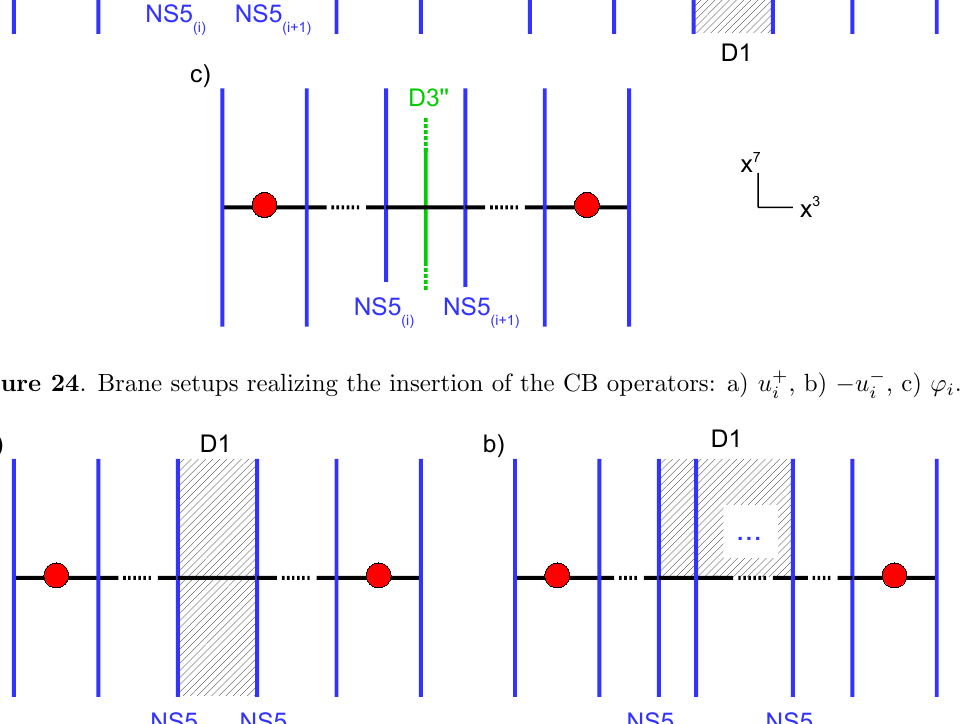
Figure 25 . The CB ring relations are derived from the con(cid:12)gurations: (a) with a D1 stretched between two adjacent NS5s, realizing (cid:0) u + stretched between two distant NS5s, ending on the D3 segments from above, realizing Q j